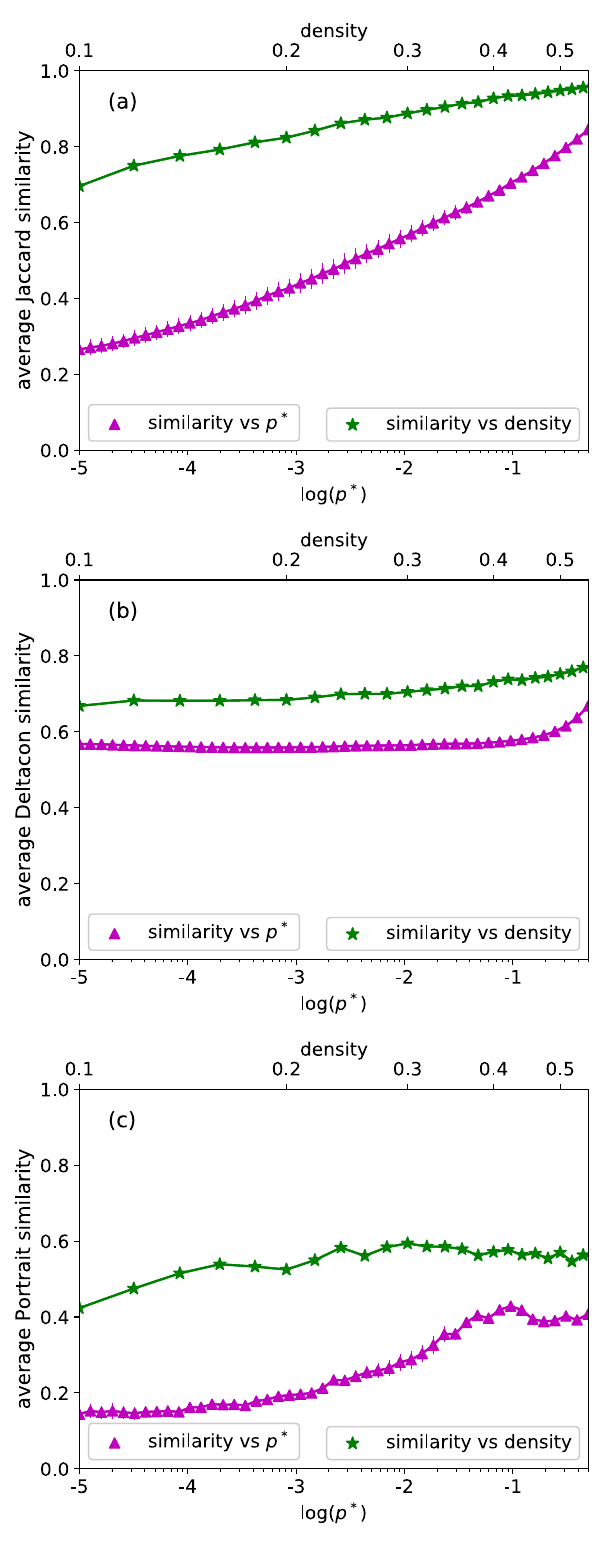
Fig. 5 Average structural similarity of the networks validated by the various null models. Error bars (not visible) represent standard deviations over choices of null model pairs. Similarity values measured through a Jaccard; b DeltaCon; c Portrait are plotted for fi ltered networks obtained with the same signi fi cance threshold p * (magenta triangles) or of equal density (green stars). The latter option reveals a higher concordance among the null models. Note how similarity has a baseline dependence on the network density: a change of a link has more impact in lower density